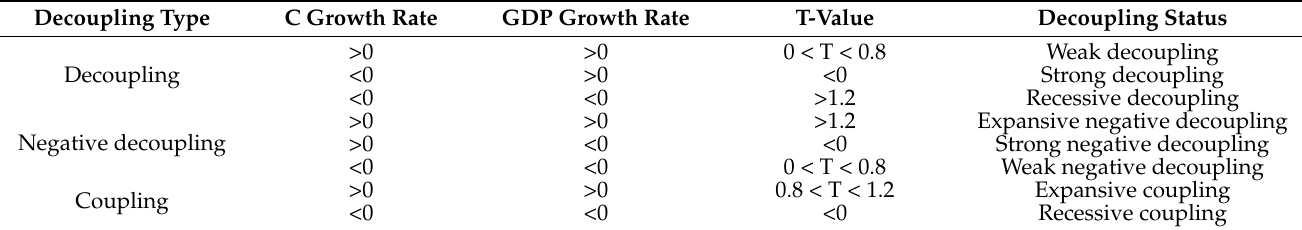
Table 2. Tapio decoupling evaluation